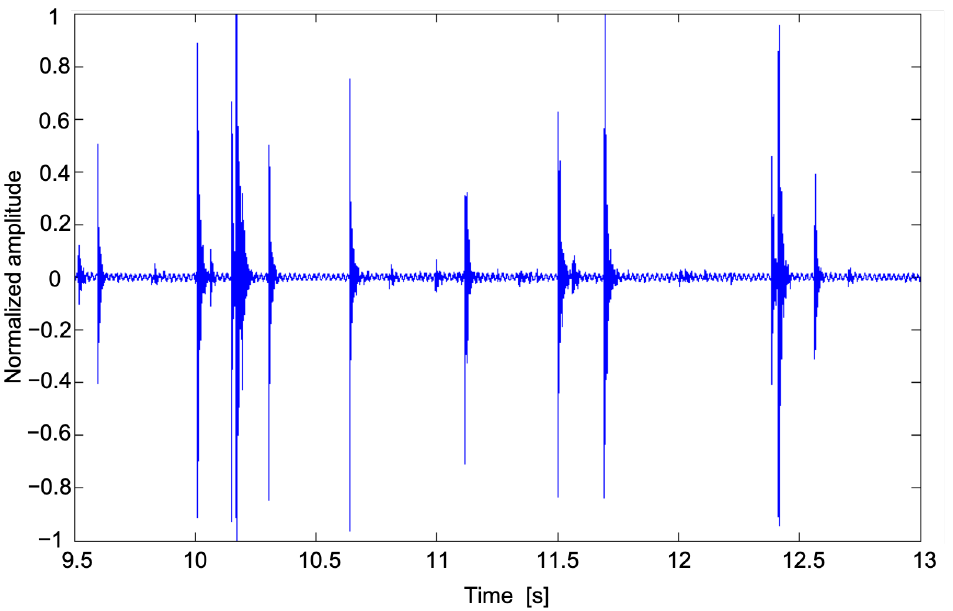
Figure 2. The sensor signal (normalized amplitude) in time